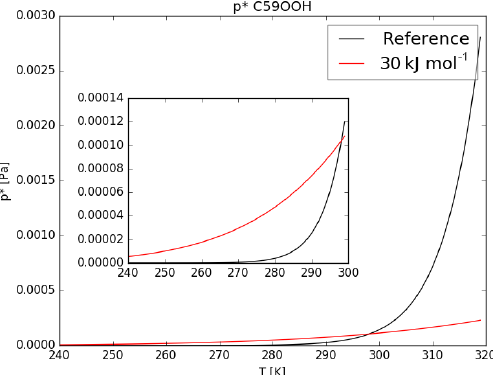
Figure 7. Curves given by the Clausius–Clapeyron equation (Eq. 1) for C59OOH. The red curve is obtained by setting (cid:49)H vap = 30kJmol − 1 , and the black one describes the parameters used in the reference run (see Table